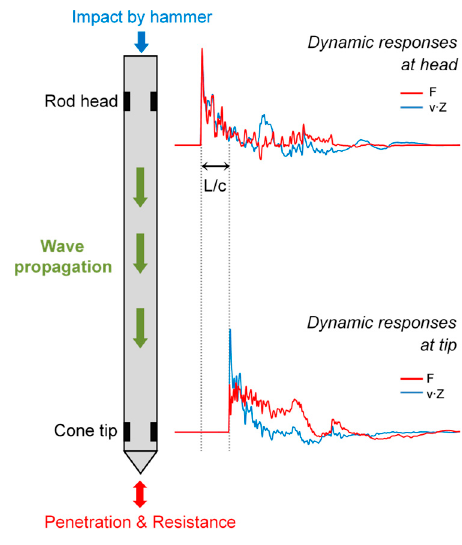
Figure 11. Schematic diagram of the force and velocity waveforms measured from the ICP. L—the total length of the rods at each depth, c—the wave velocity through steel.